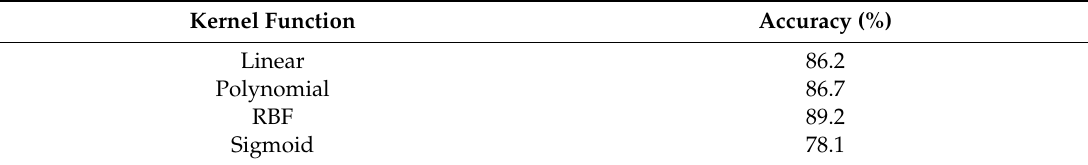
Table 4. Comparison of the four kernel functions.